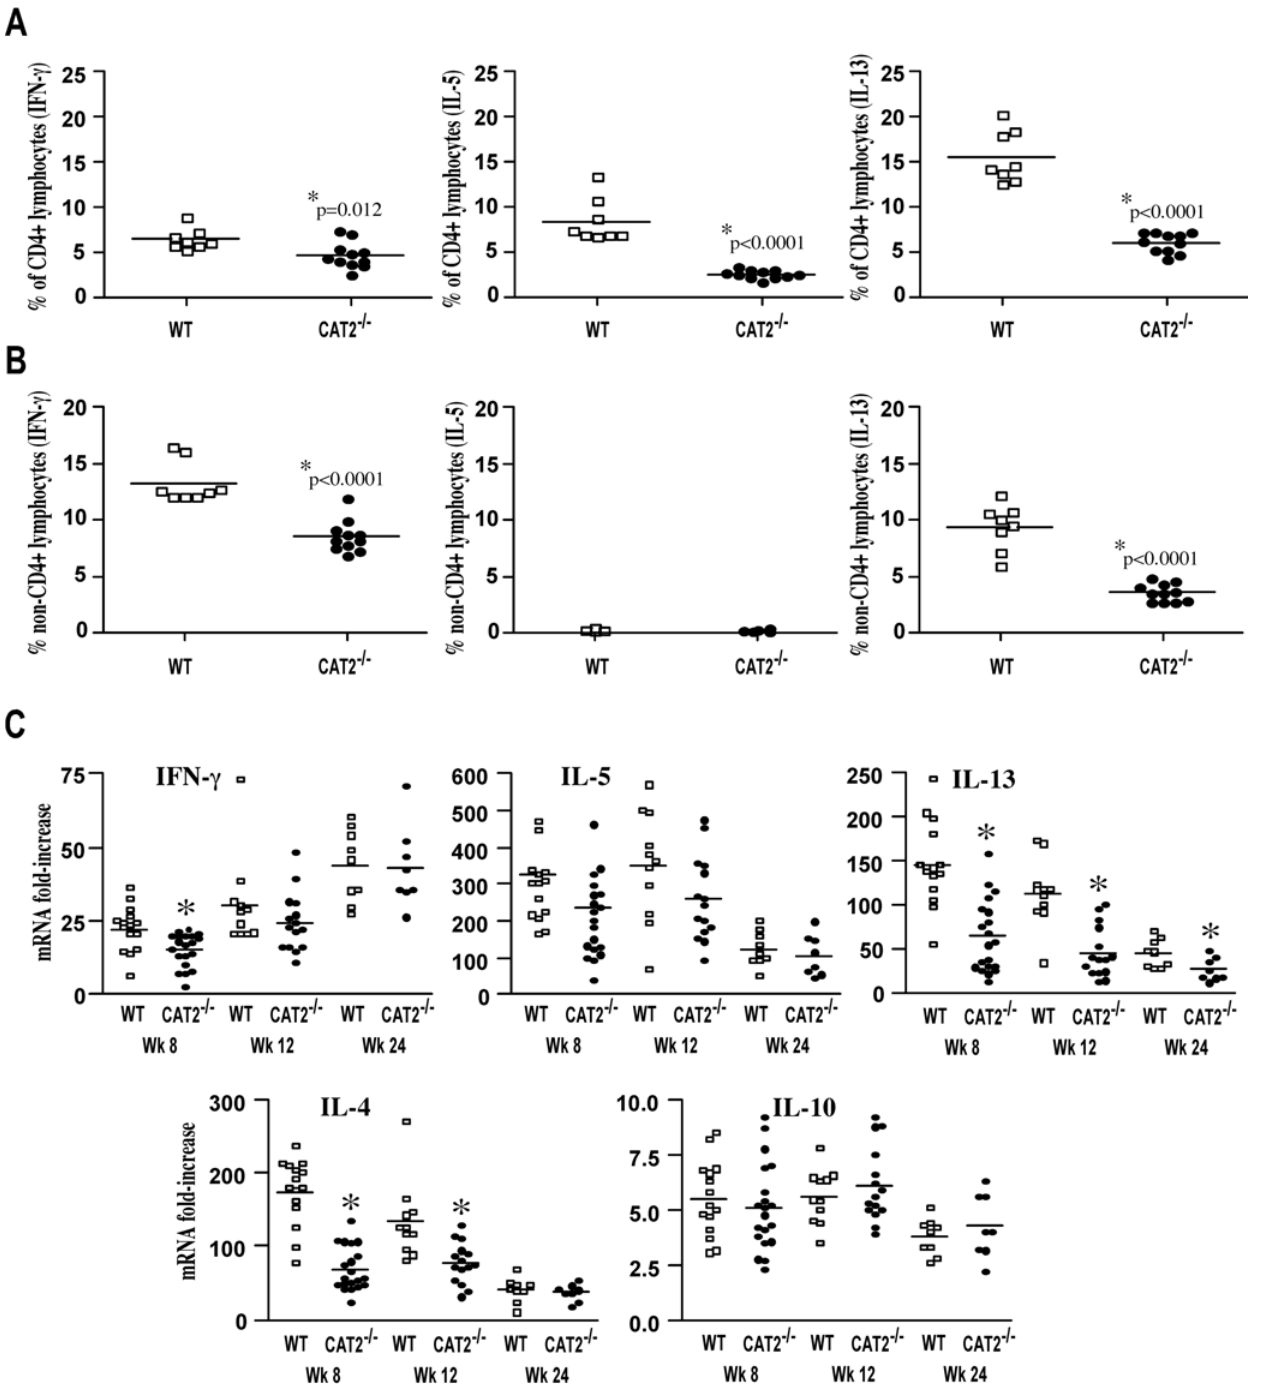
Figure 5. T H 1/T H 2 cytokine responses are reduced in infected CAT2 2 / 2 mice. A. Leukocytes derived from the granulomatous livers of 8 wk S. mansoni infected mice were stimulated with PMA/Ionomycin/BFA for 3 hr and then stained for CD4, IFN- c , IL-5 and IL-13. The data show the percentage of CD4 + lymphocytes producing a specific cytokine. Results for individual mice are shown and statistically significant differences are indicated in the figure. B. Frequency of non-CD4 + lymphocytes producing specific cytokines. C. Relative mRNA levels of ifn- c , il-5 , il-13 , il-4 , il-10 in S. mansoni infected liver tissue were determined by real-time Q-RT-PCR (wk 8,12 and 24), by normalizing mRNA levels to expressed, endogenous HPRT mRNA. Fold increases in relative mRNA levels were determined by the ratio of normalized infected mRNA to uninfected mRNAs. Results from individual mice are shown. The * symbol denotes significant differences between WT and KO mice at that time point, p , 0.05.